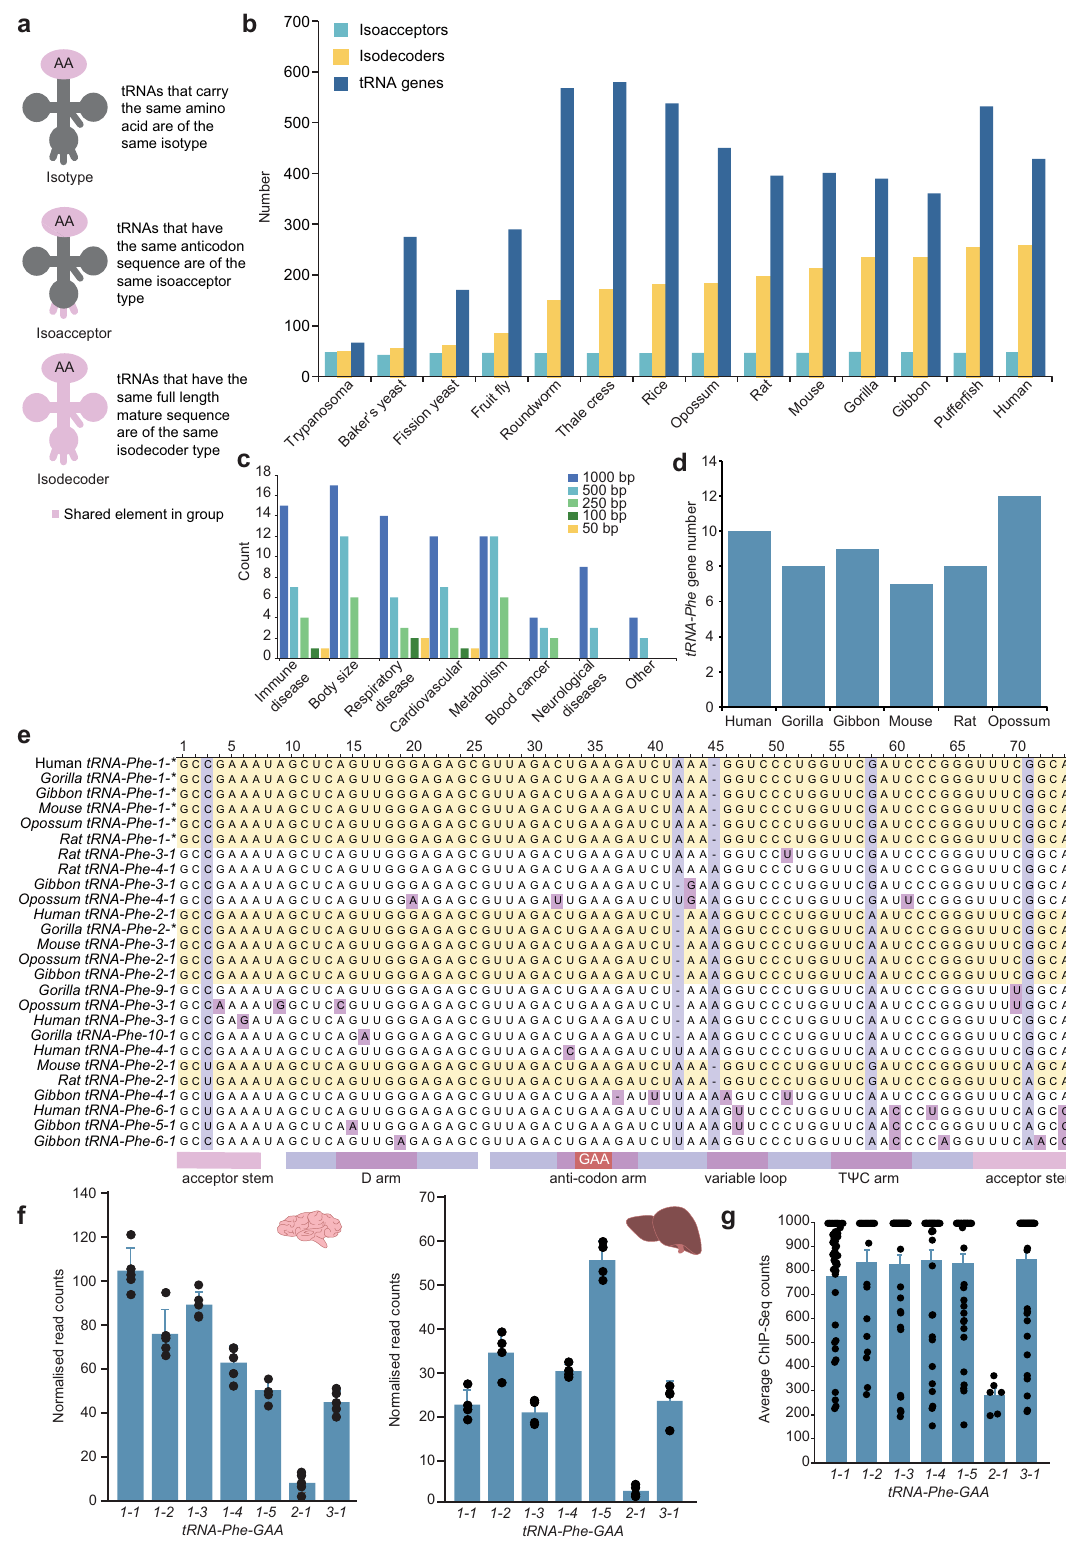
Gibbon tRNA-Phe-1-* Mouse tRNA-Phe-1-* Opossum tRNA-Phe-1-* Rat tRNA-Phe-1-* Rat tRNA-Phe-3-1 Rat tRNA-Phe-4-1 Gibbon tRNA-Phe-3-1 Opossum tRNA-Phe-4-1 Human tRNA-Phe-2-1 Gorilla tRNA-Phe-2-* Mouse tRNA-Phe-3-1 Opossum tRNA-Phe-2-1 Gibbon tRNA-Phe-2-1 Gorilla tRNA-Phe-9-1 Opossum tRNA-Phe-3-1 Human tRNA-Phe-3-1 Gorilla tRNA-Phe-10-1 Human tRNA-Phe-4-1 Mouse tRNA-Phe-2-1 Rat tRNA-Phe-2-1 Gibbon tRNA-Phe-4-1 Human tRNA-Phe-6-1 Gibbon tRNA-Phe-5-1 Gibbon